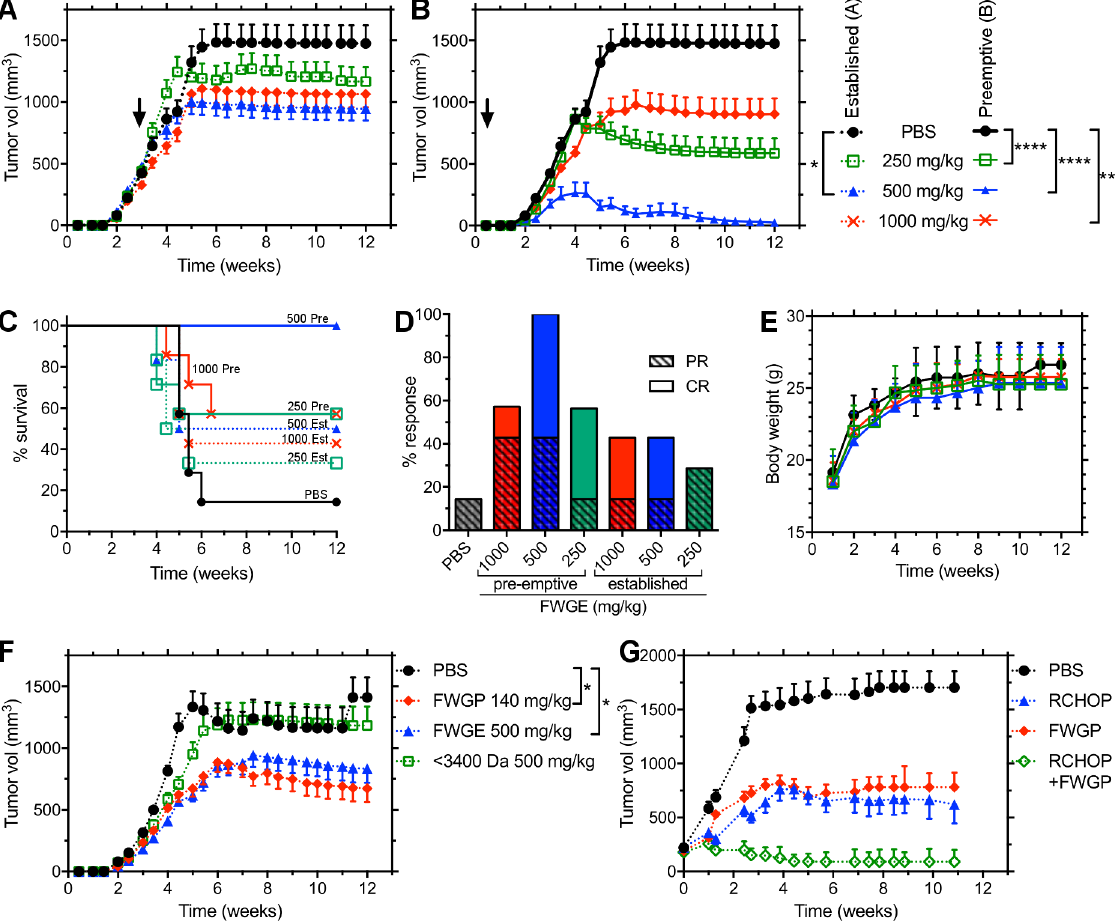
Fig 3. In vivo activity of FWGE and FWGP. Raji cells were implantedin nu/nu mice and animalswere treated with 250, 500 or 1000mg/kg of FWGE by gastric gavage5 days/week; treatment started after tumor reached > 100 mm 3 (A) or on the day the xenograft was implanted (B); control animalswere treated with PBS. (C) Overall survival of animalsin A and B. Curves are labeled with dose (mg/kg) and preemptive (Pre) or established (Est) tumor model. (D) Tumor progression was recordedas complete response(CR) or partial response (PR) to treatment. (E) Toxicity was assessed by monitoringanimalweight; additional parameters are presented in S6 Fig (F) Animals with established Raji tumors were treated with FWGE, the FWGP subfractionor the subfraction < 3400 Da in molecularweight (n = 8 animals/groups, * p < 0.05). (G) Animals with established Raji tumors were treated with FWGP (140 mg/kg), with the RCHOP regimen or both. Data are presented as the averageof tumor volume ± SEM (n = 8 animals/group, * p < 0.05; ** p < 0.01; **** p < 0.0001, ANOVA with Holm-Sidak multiple comparison). All animalexperiments were performed under IACUC